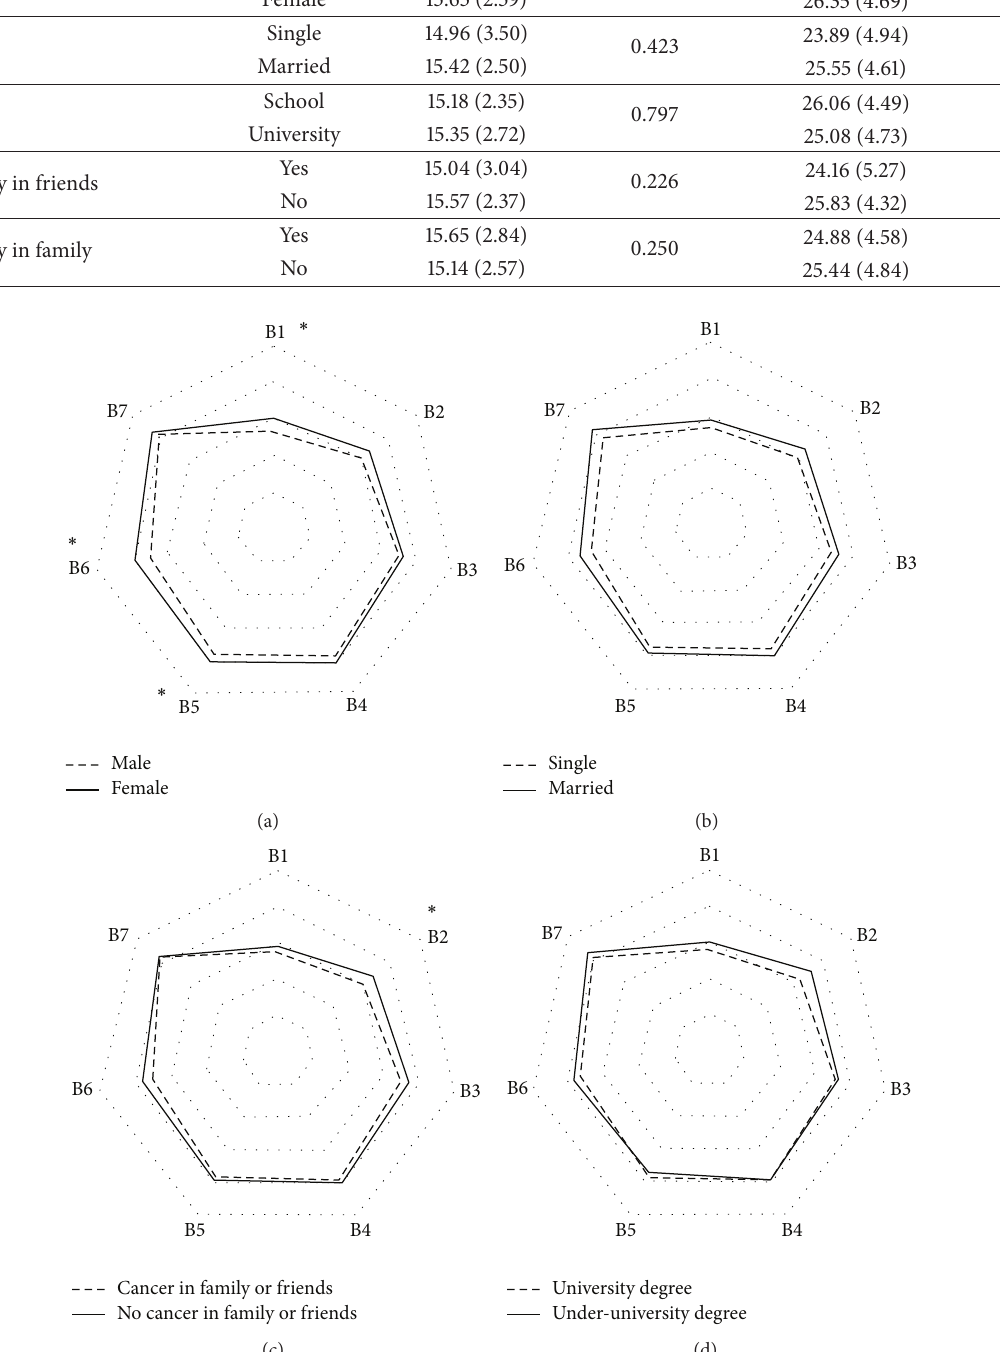
Figure 1: Radar chart depicting mean total score of each preventive behavior according to (a) gender, (b) marital status, (c) history of cancer in family or friends, and (d) educational status. B1–B7: different behaviors according to coding in Table 3. ∗ means significant difference in mean values of behavior in two groups ( 𝑝 < 0.05